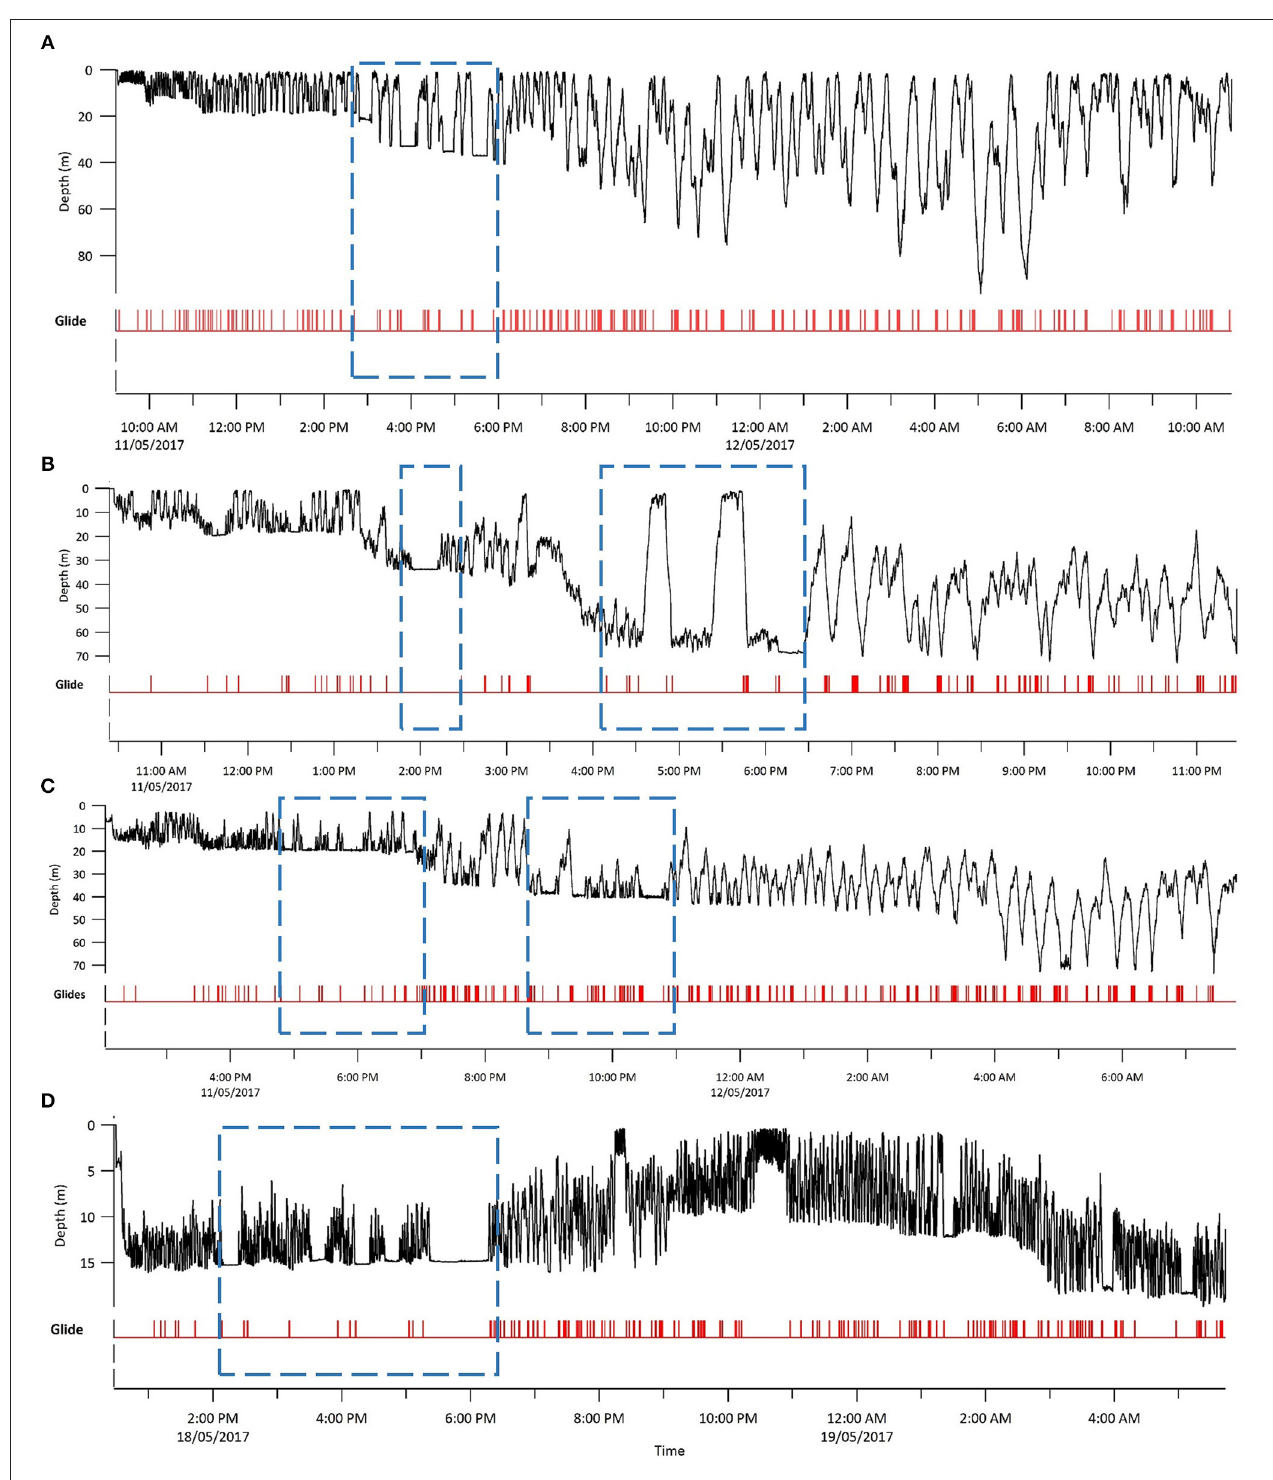
FIGURE 3 | Entire depth record and gliding behavior for each tagged sandbar shark. Glides are marked where the mask analysis determined gliding was occurring. Dashed blue squares denote extended periods of U-shaped diving, and associated looping behavior. (A) Shark 1; (B) Shark 2; (C) Shark 3; and (D) Shark 4. Note that both x - and y -axes scales differ between